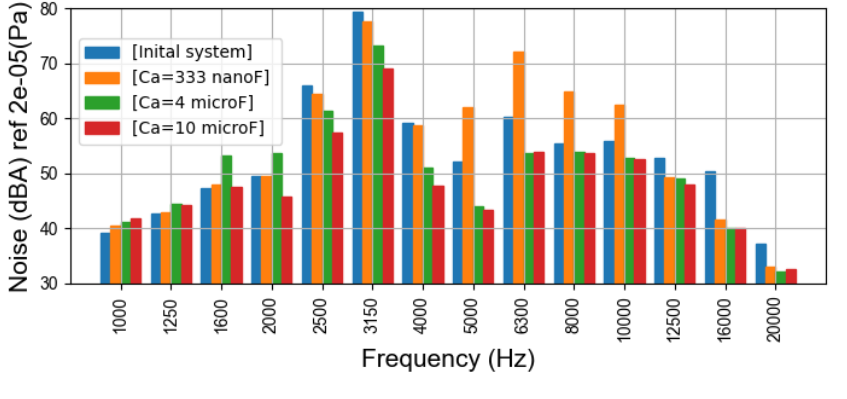
Figure 10. One-third octave spectra of the sound pressure in dB with f swi = 3 kHz.